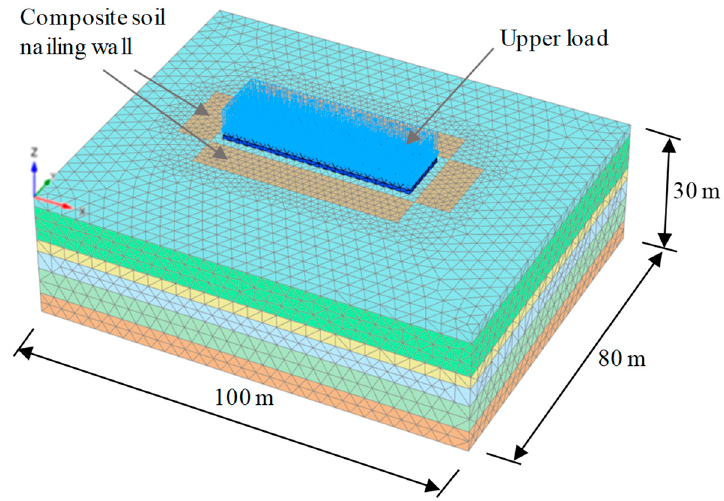
Figure 5. Three-dimensional (3D) mesh model.